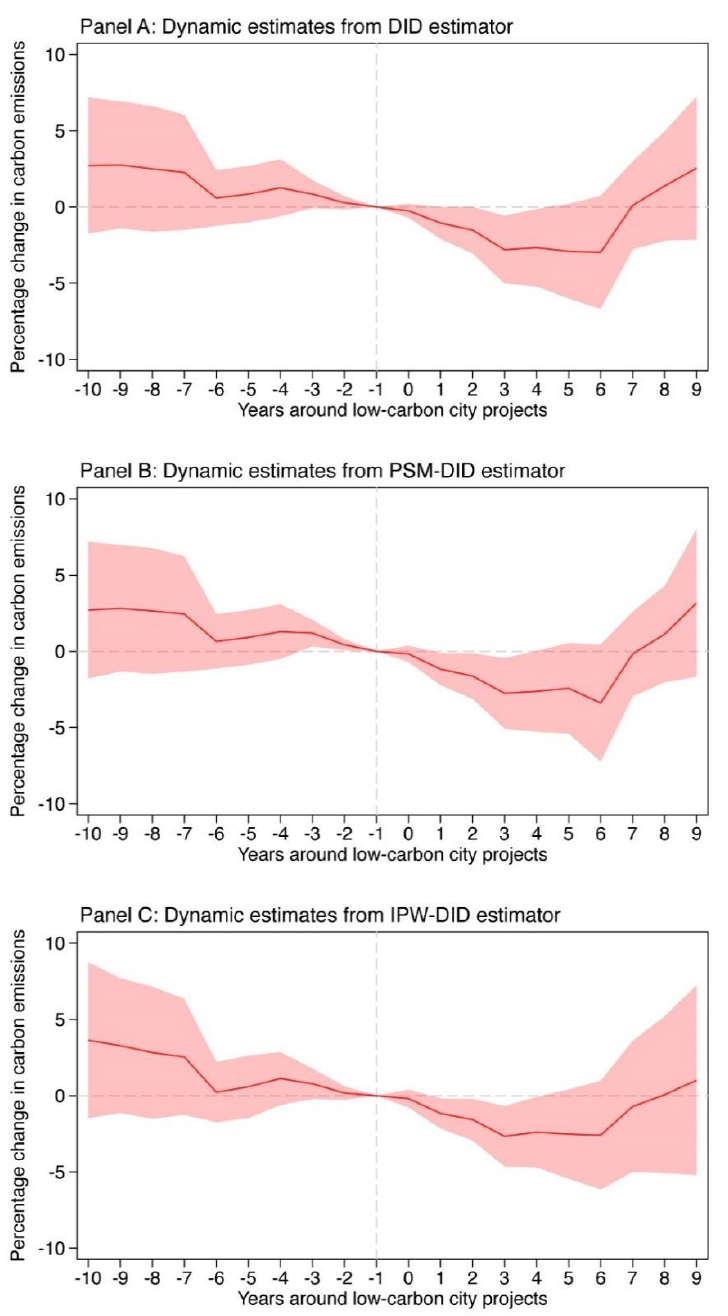
Figure 1. Dynamics of the impact of low-carbon city pilot projects on carbon emissions. (Panel A ) presents the results from difference-in-differences estimators. (Panel B ) presents the results from propensity-score-matching difference-in-differences estimators. (Panel C ) presents the results from inverse-probability-weighting difference-in-differences estimators.